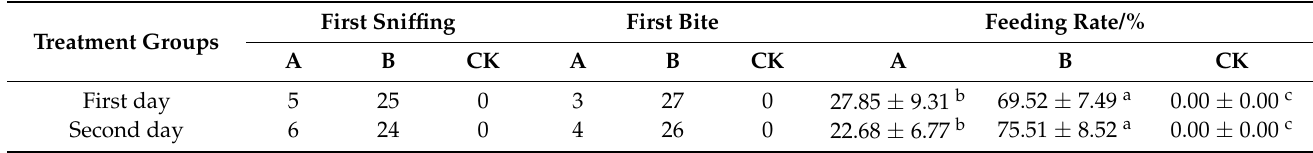
Table 8. Preference of cat food attractants in different groups. Groups A, B, and CK were the same as